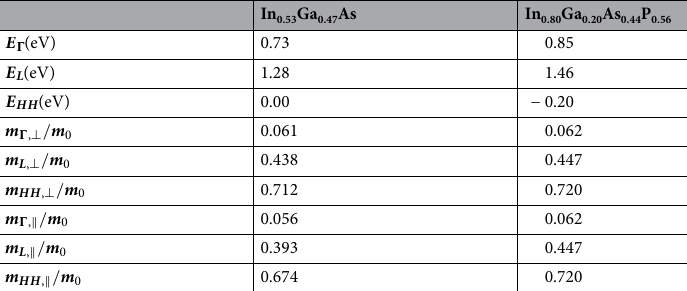
Table 1. Material parameters at 300 K, used for the band structure calculation. They are based on interpolation from Ref. 35 , band offset studies 36 , and adjustment for quantization effects 37–41 according to measured photoluminescent energy peaks in this work. ll and ⊥ denote directions parallel and perpendicular to the hetero interfaces,